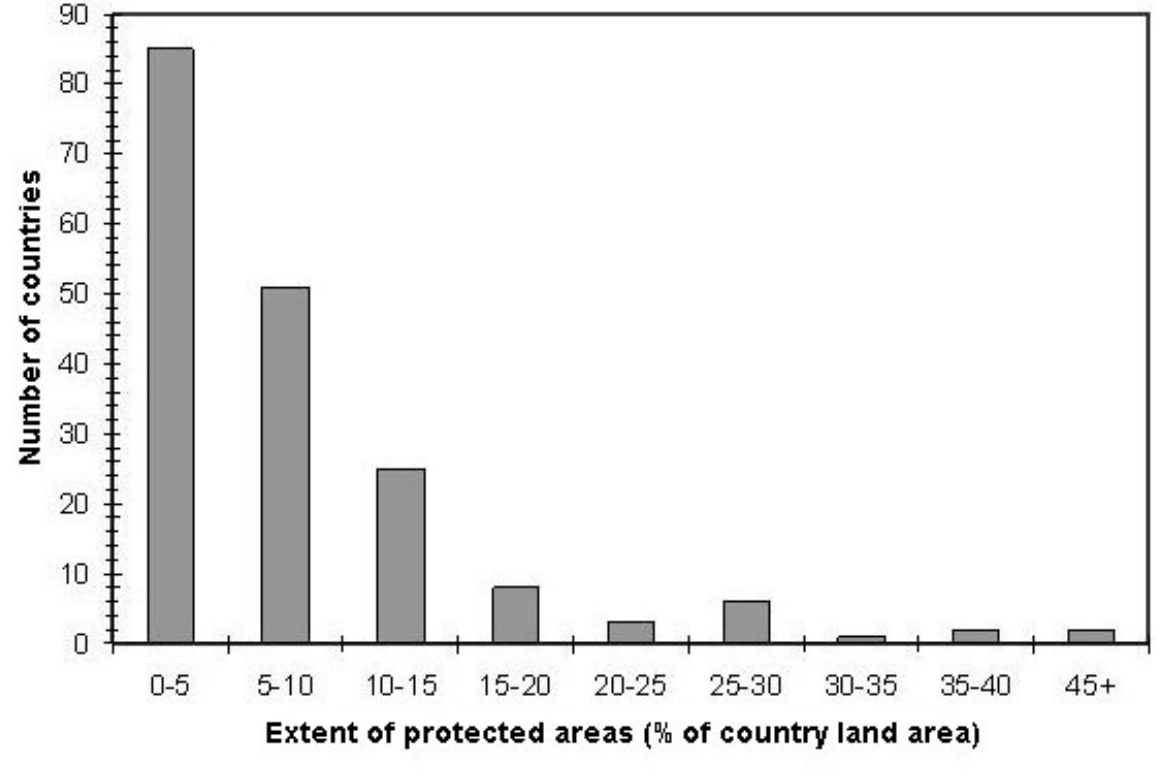
Fig. 3. Frequency distribution of land protection for 183 countries. The per country average is 7.9%, compromising 11.5% of the global terrestrial land area (Chape et al.